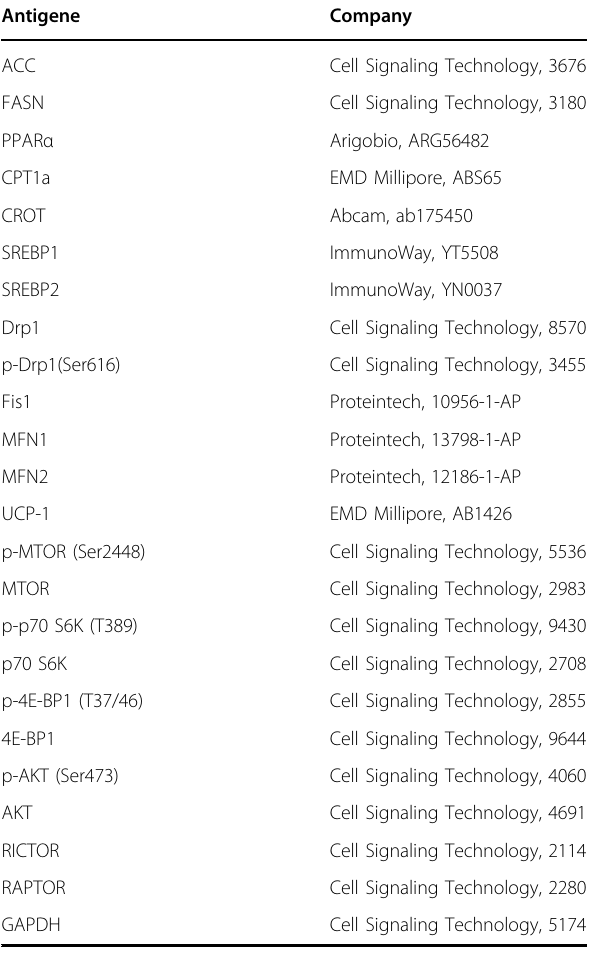
Table. 1 Antibodies for immunoblots and immunohistochemistry.